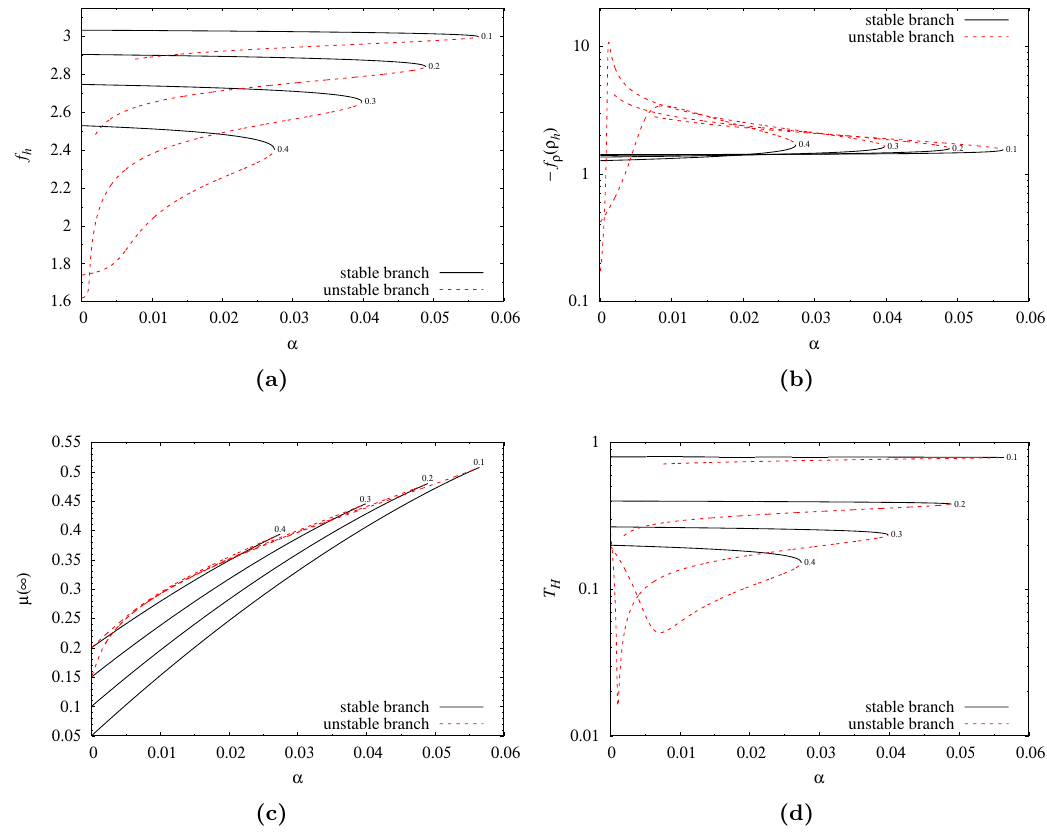
Figure 20 . Stable (black solid lines) and unstable (red dashed lines) branches of solutions in the 2+8 model with (cid:13) = 1 : (a) the value of the pro(cid:12)le function at the horizon, f h ; (b) the derivative of 3 the pro(cid:12)le function at the horizon, f (cid:26) ( (cid:26) h ); (c) the ADM mass, (cid:22) ( 1 ); (d) the Hawking temperature T H , all as functions of the gravitational coupling, (cid:11) . The numbers on the (cid:12)gures indicate the di(cid:11)erent values of (cid:26) h = 0 : 1 ; 0 : 2 ; 0 : 3 ; 0 :